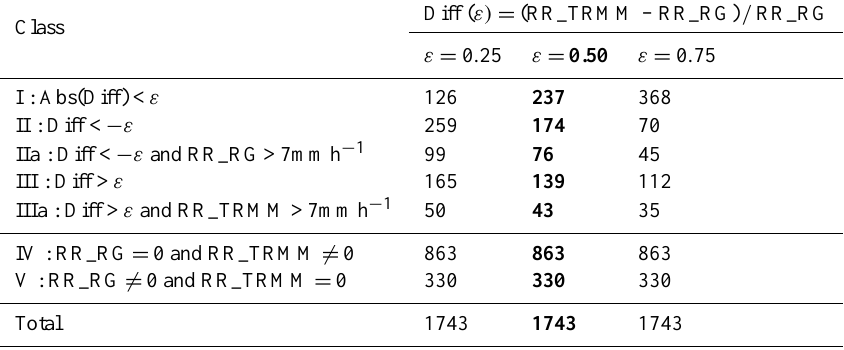
Table 4. Classification of TRMM 2A25 reflectivity profiles as a function of the difference ( ε ) (RR_TRMM2A25 – RR_RG) / RR_RG that represents the relative error of the 2A25 estimates with respect to the raingauge observations. The timescale of integration is 10min for RG0XX and RG1XX and 30min for RG3XX, which corresponds to the minimum error bias for the period of record. Bold values correspond to ε = 0 .